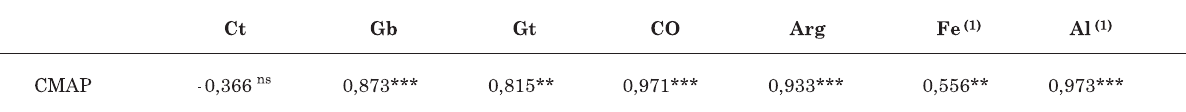
(1) Totais pelo ataque nítrico-perclórico (HNO respectivamente.